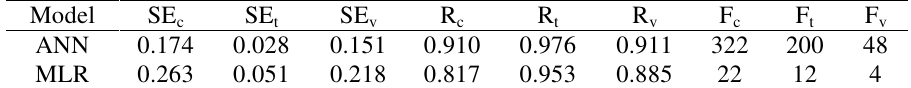
Table 5. Comparison of the statistical parameters obtained using the ANN and MLR models a